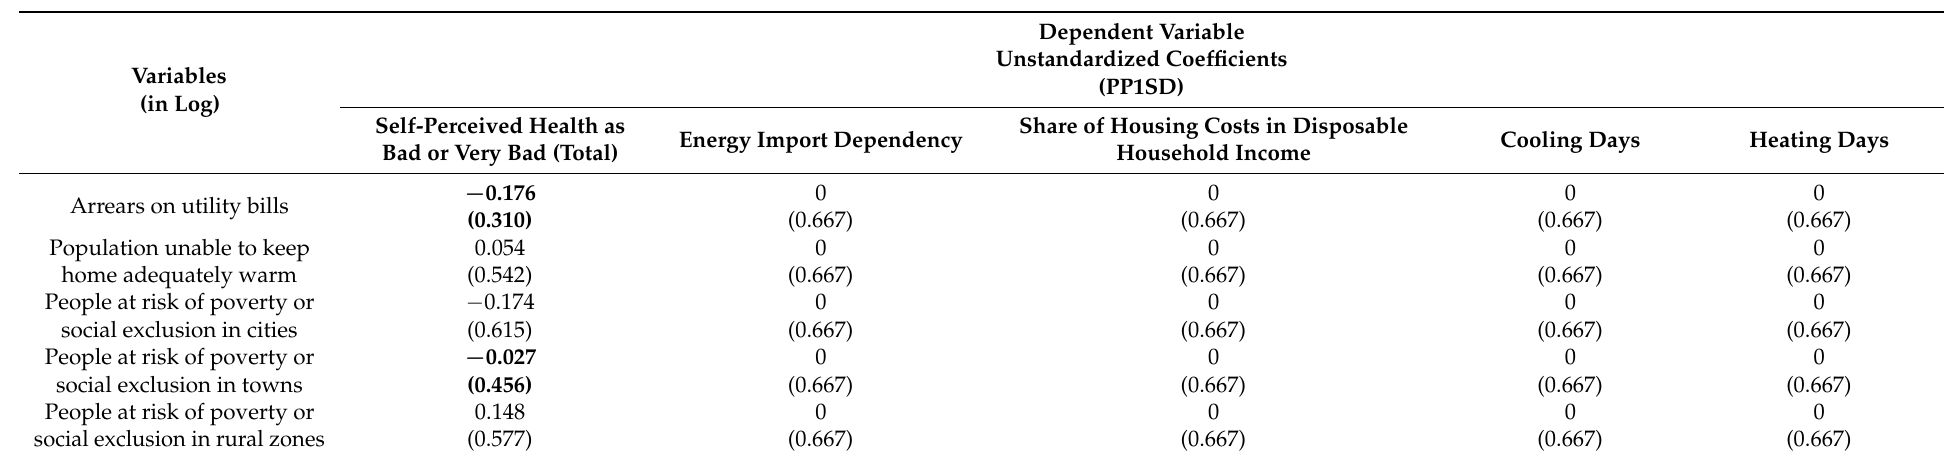
Table 12. The results of generalized ridge regressions for